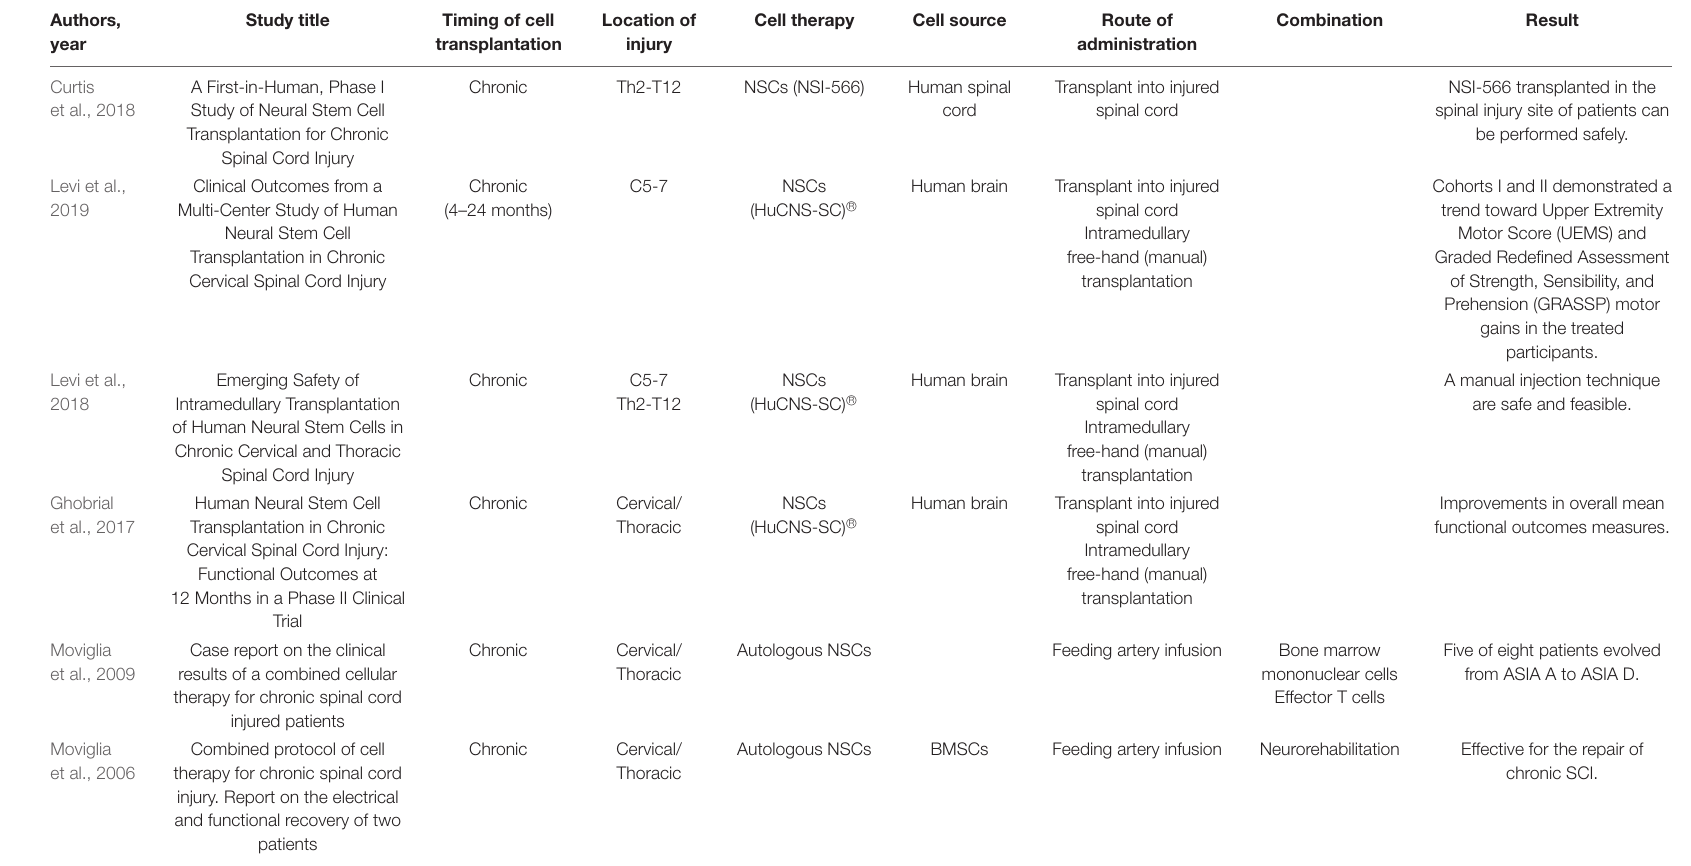
TABLE 3 | Characteristics of included clinical trials for chronic